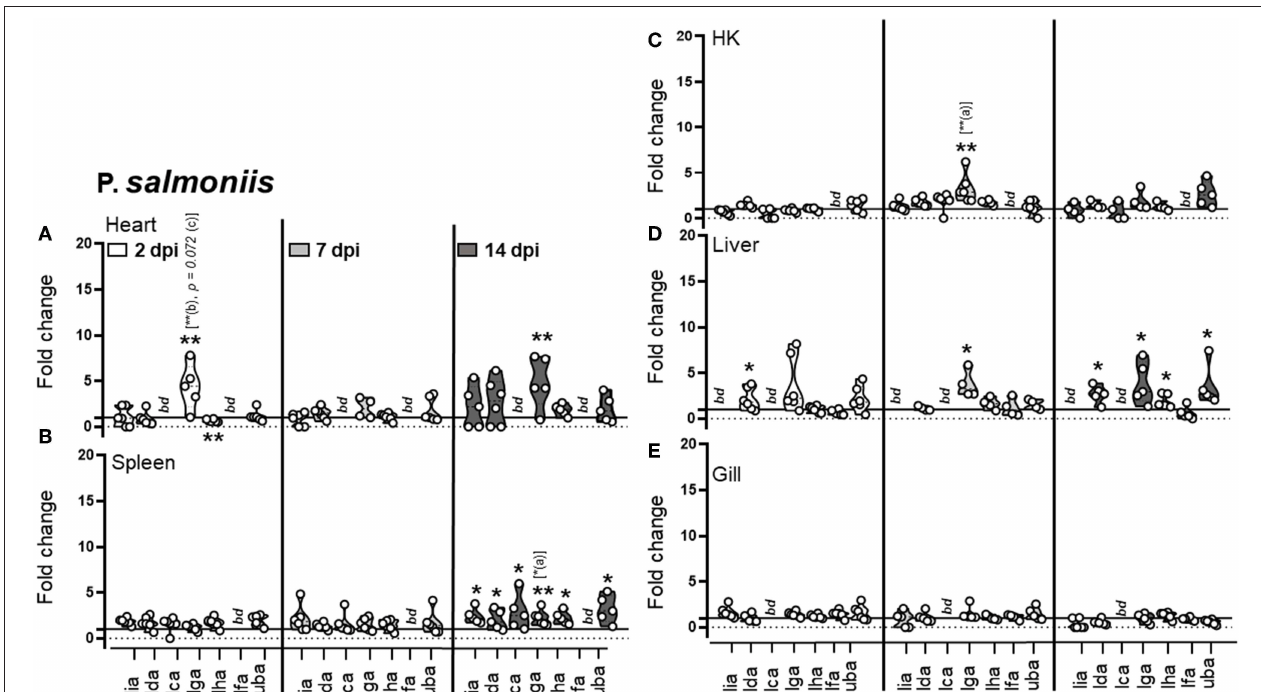
FIGURE 3 | Expression of MHC class I L lineage genes in different tissues of Atlantic salmon following i.p. P. salmonis challenge. Pre-smolt Atlantic salmon were intra peritoneal (i.p) injected with 3 × 10 6 CFU P. salmonis or an equivalent volume of PBS and samples were collected at 2, 7, and 14 days post infection. (A–E) Fold change in the expression of different L lineage MHC class I genes ( lia, lda, lca, lga, lha, and lfa ) and classical MHC class I ( uba ) in different tissues at various times post challenge ( n ǫ 6) relative to the control groups from the same time point ( n ǫ 6) is shown. Each dot represents an individual fish and the line intersecting the y-axis at 1 represents the unstimulated control that the fold change of the treatments is in relation to. Asterisks above each violin plot indicates the strength of significance compared to PBS injected controls, and letters above each violin represent statistical differences among the different time points for each individual gene ( a = 2 dpi; b = 7 dpi, and c = 14 dpi), * p < 0.05 and ** p < 0.01. bd, below